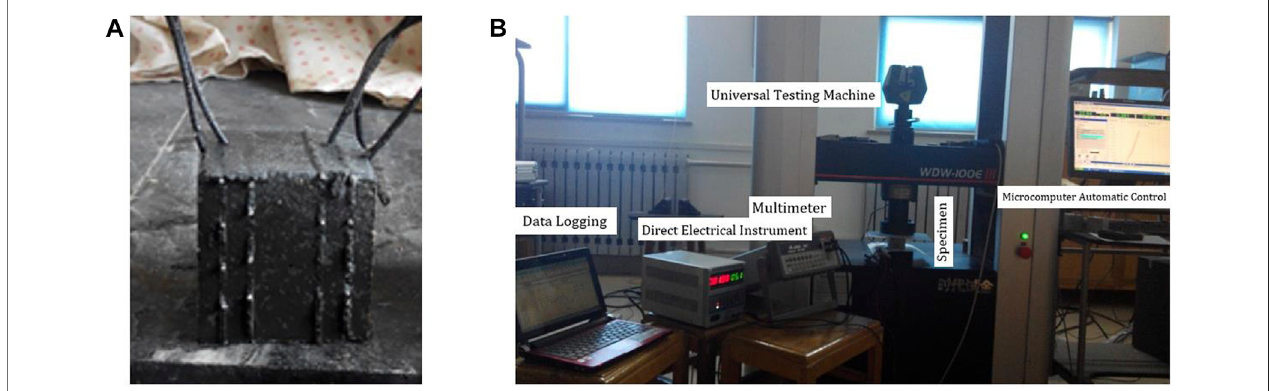
FIGURE 2 | (A) Cement-based composites with GNP specimen for electrical resistance test; (B) Electrical resistance test on site.